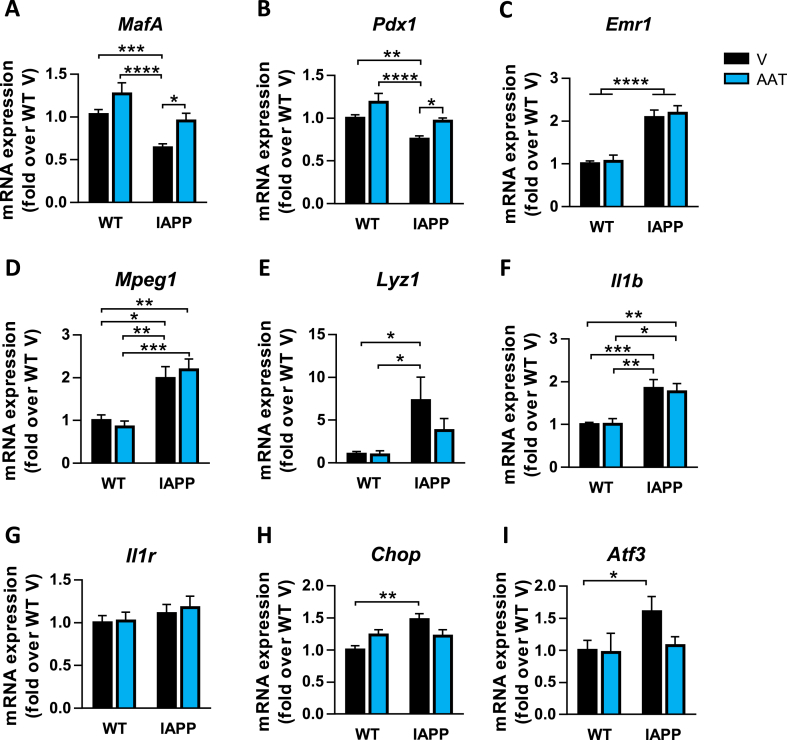
Effects of AAT treatment on gene expression in pancreatic islets from hIAPP-Tg mice. (A–I) mRNA expression levels of (A) MafA, (B) Pdx1, (C) Emr1, (D) Mpeg1, (E) Lyz1, (F) Il1b, (G) Il1r, (H) Chop, and (I) Atf3 in pancreatic islets isolated from WT and hIAPP-Tg (IAPP) mice treated with vehicle (V) or AAT. Gene expression data were normalized against Hprt1 and are shown relative to WT-V levels, which were set arbitrarily to 1. Results are expressed as the mean ± SEM from two independent experiments (n = 9–16 mice/group). ∗P < 0.05; ∗∗P < 0.01; ∗∗∗P < 0.001; ∗∗∗∗P < 0.0001.